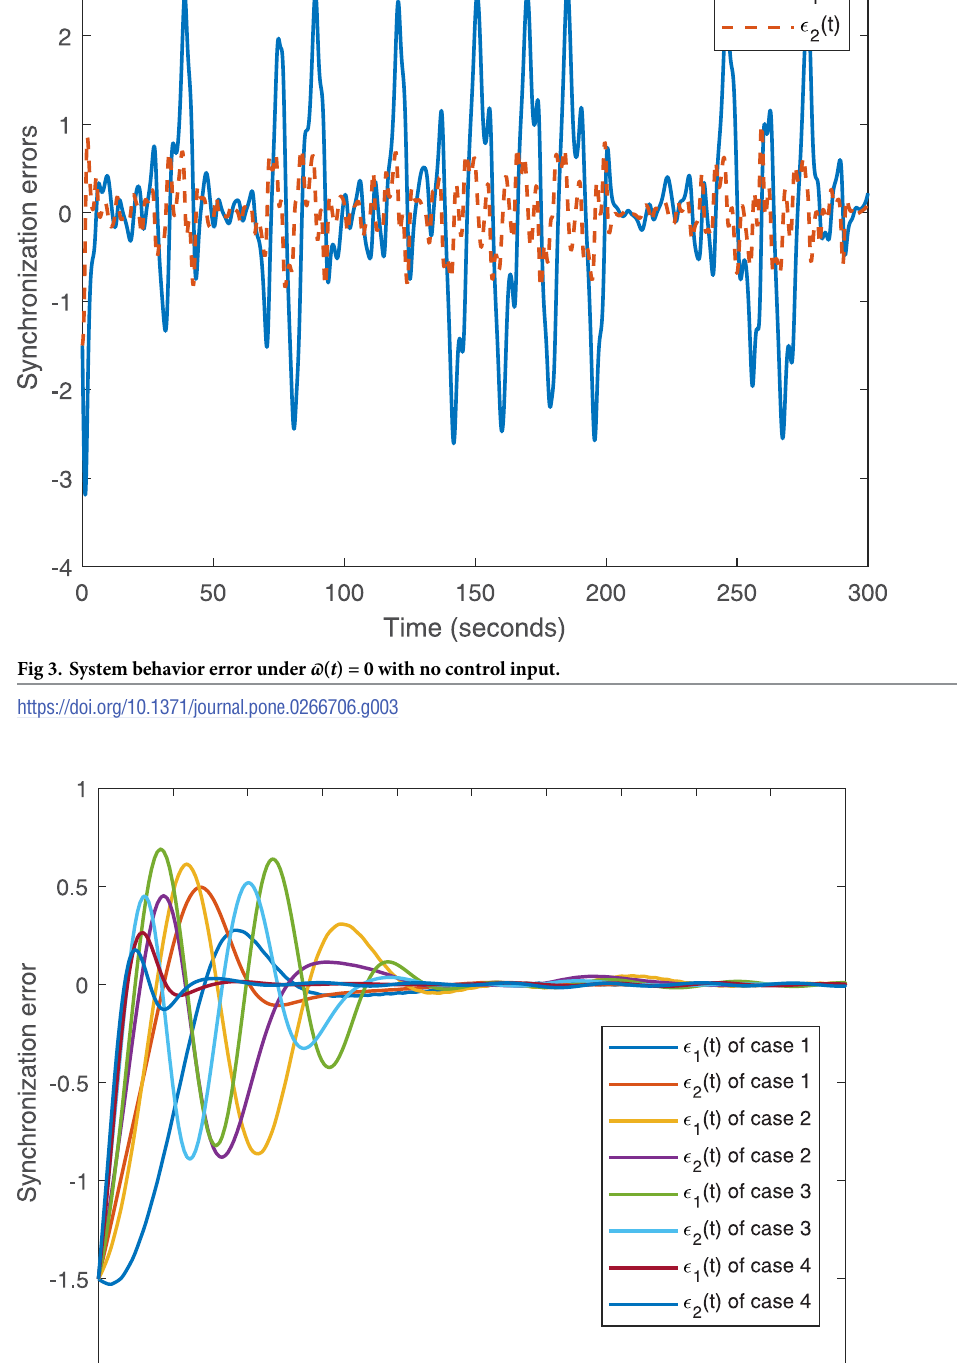
PLOS ONE | https://doi.org/10.1371/journal.pone.0266706 April 8,